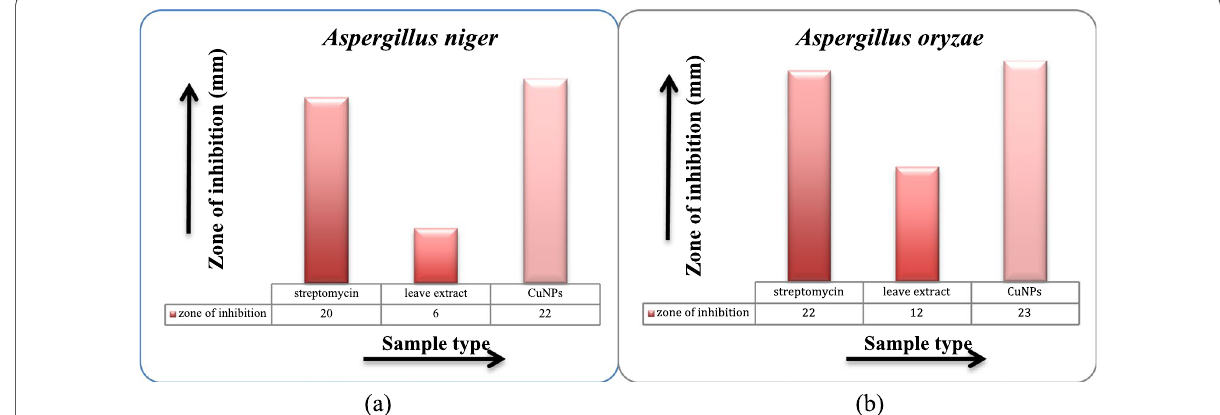
Fig. 6 Anti‑Fungal activity of Grewia asiatica leave extract and copper nanoparticles against Aspergillus niger and Aspergillus